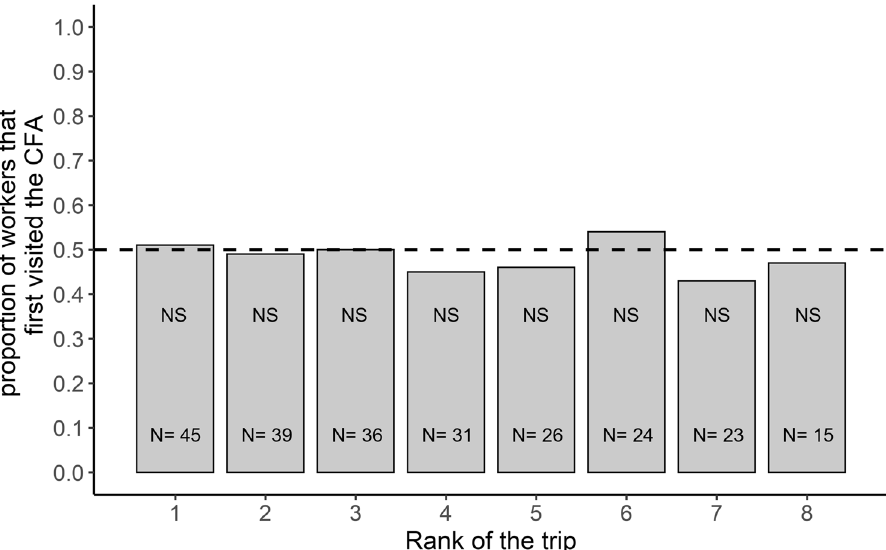
Figure 5. Individual experiment: proportion of foragers that first visited the contaminated foraging area (CFA) over the first eight trips. N values represent the numbers of ants for each trip’s rank. A binomial test was carried out for each trip’s rank. Binomial tests; NS: